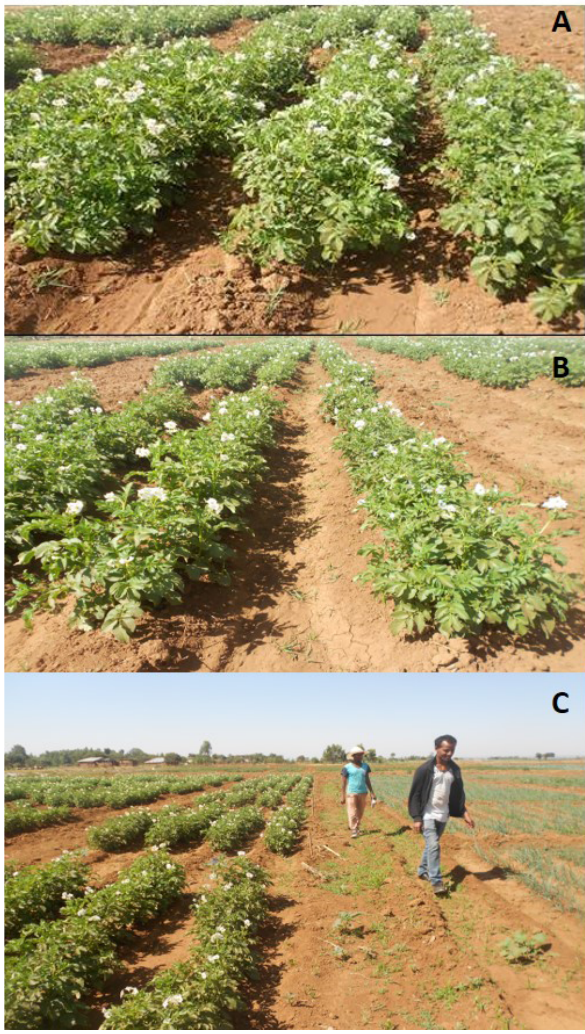
Figure 3. Crop aboveground biomass at 95 days after planting. A: Customary irrigation, B: partial root-zone drying (PRD) with siphons and C: PRD without